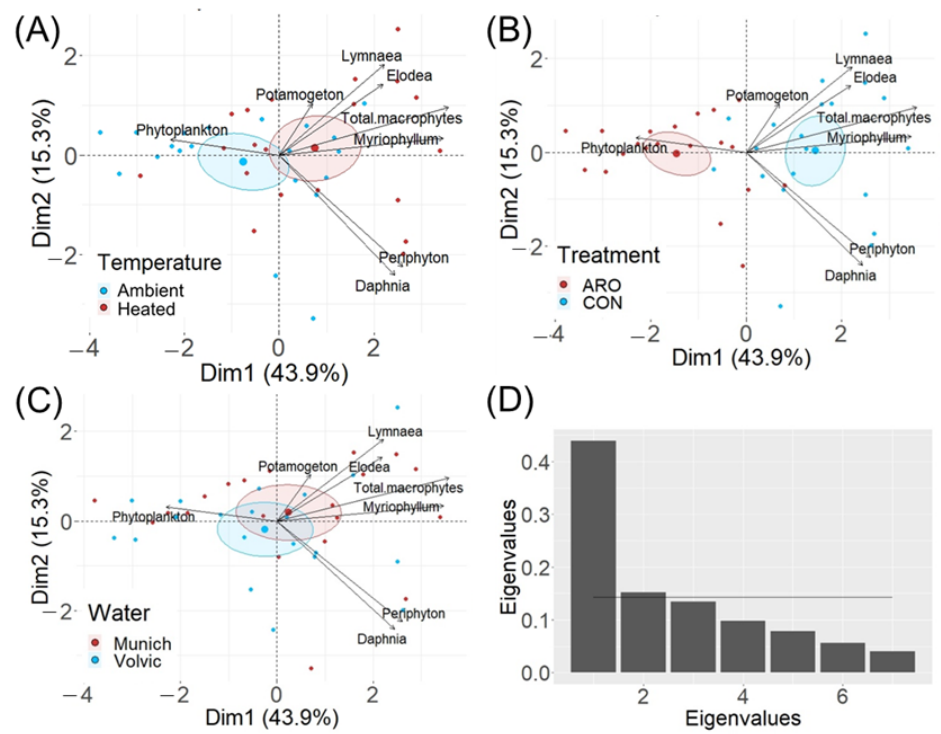
Figure 2. Microcosms. Principal components analysis plot showing the most significant axes and all response variables. The temperature, treatment and water effects are projected as supplementary data: ( A ) ambient (blue) or heated (red), ( B ) CON (blue) or ARO (red) and ( C ) Volvic (blue) or Munich well water (red). ( D ) Eigenvalue scores of the 7 main axes.